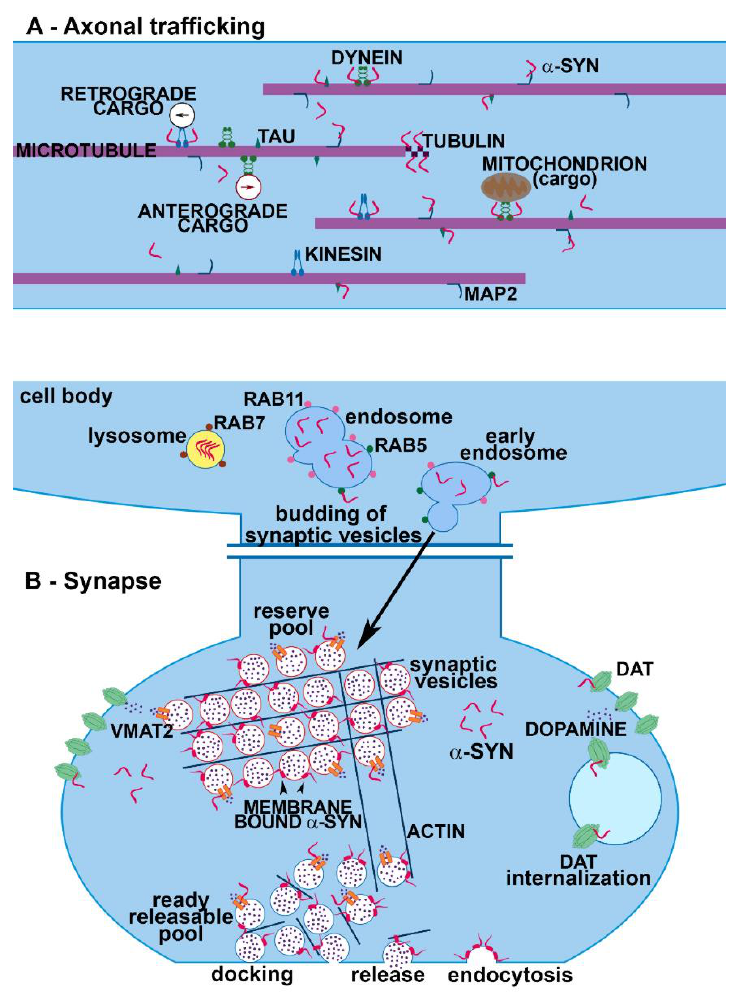
Figure 2. Role of α -syn in axonal trafficking and synaptic terminals. The image is representative of α -syn interactome in axons ( A ) and synapses ( B ). ( A ) Alpha-synuclein interacts with different motor proteins mediating axonal transport, such as kinesins and dyneins, as well as with microtubules, where it contributes to the polymerization of the single tubulin molecules. ( B ) At the synapse α -syn plays multiple important roles in SVs trafficking and refilling and in neurotransmitter release and reuptake. Alpha-synuclein aggregation perturbs the distribution and function of its synaptic partners.